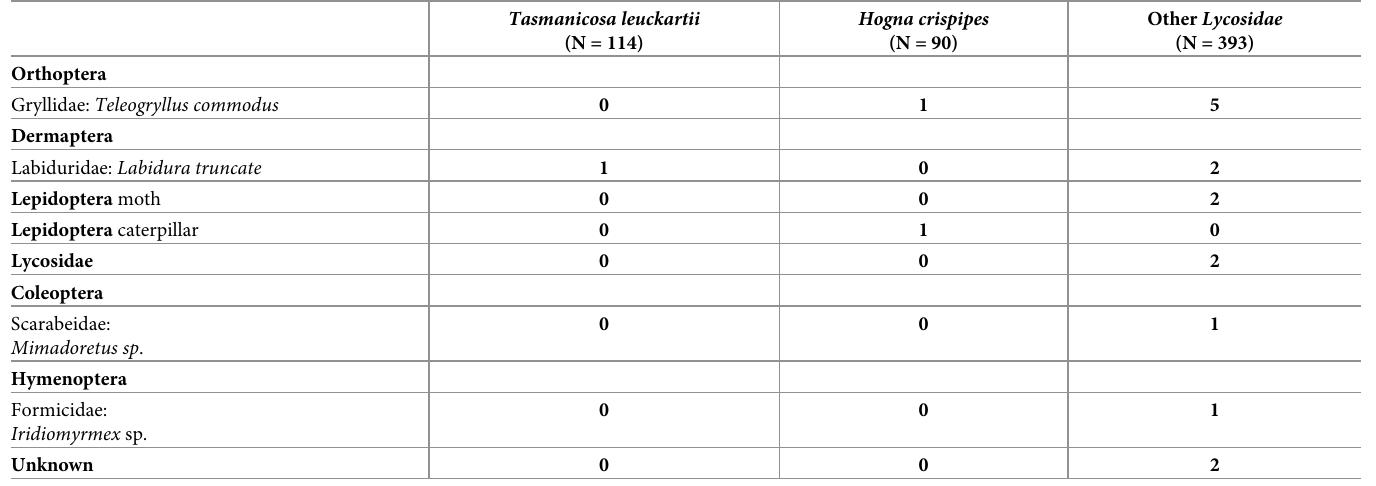
Table 1. Wolf spider prey observed in visual surveys around edges of cotton